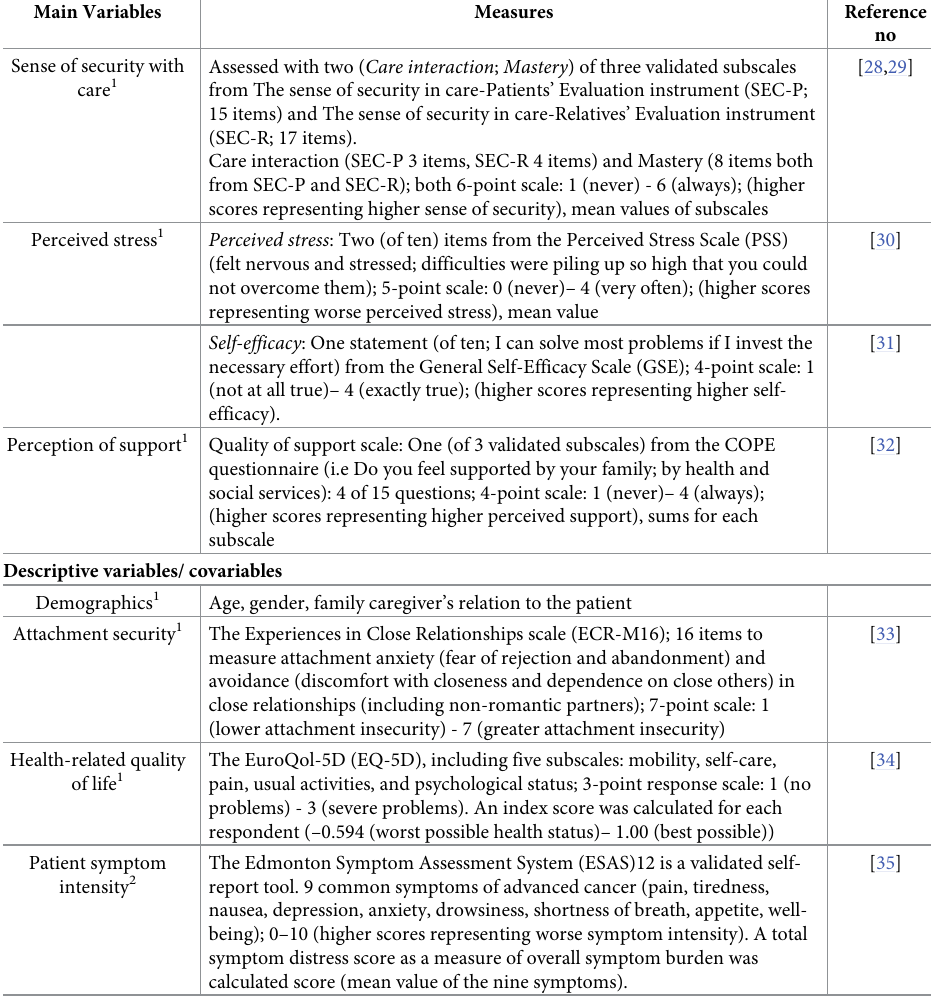
Table 1. Overview of measured variables regarding patients’ and family caregivers’ experiences of stress, support and sense of security during palliative care asked during the